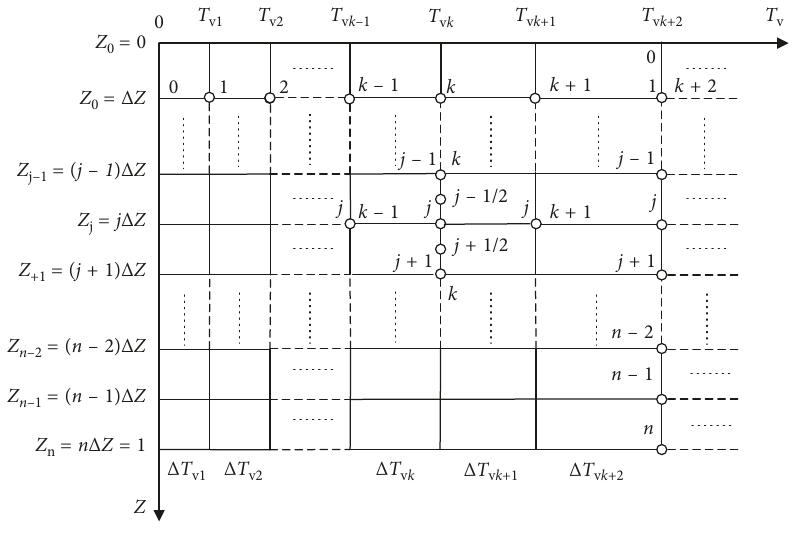
Figure 5: A differential grid in the x - T